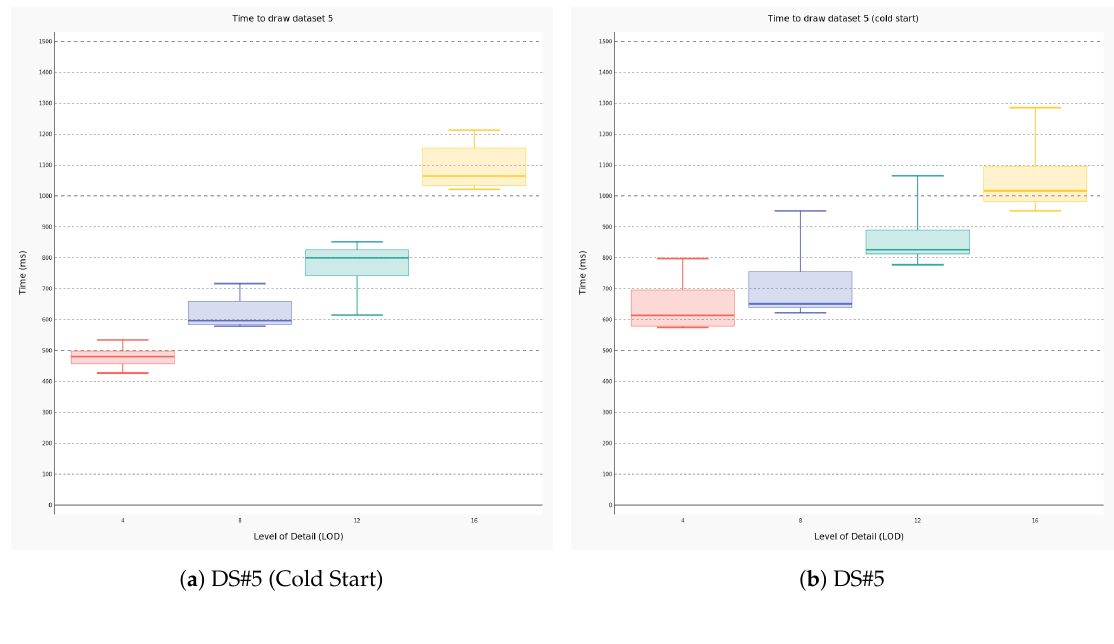
Figure 22. Time to represent DS#5.